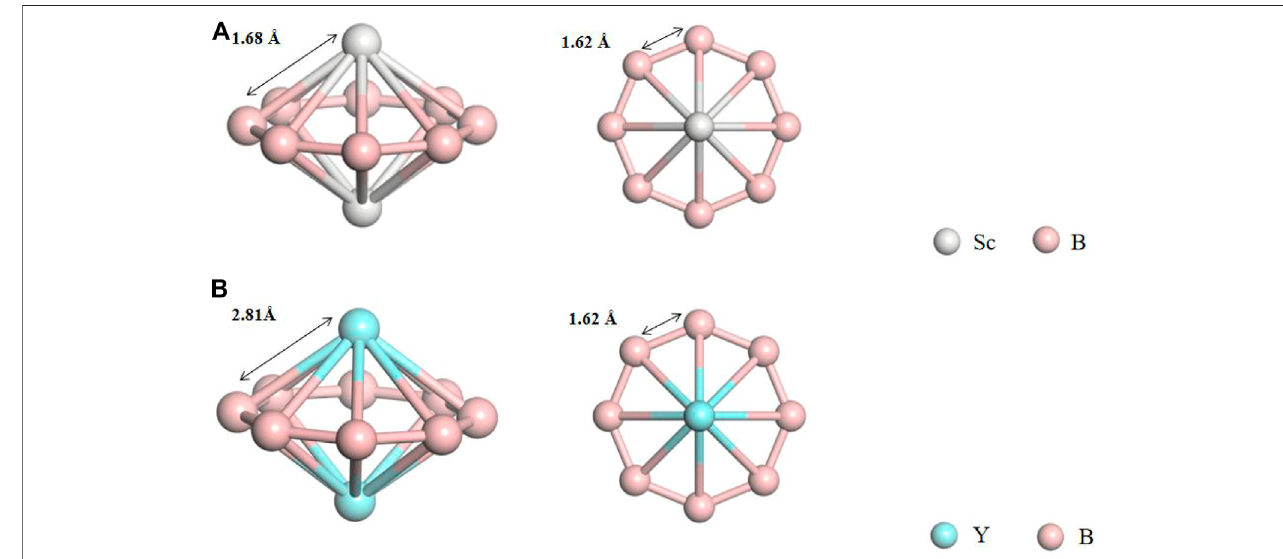
FIGURE 1 | Side and top views of the optimized Sc 2 B 8 (A) and Y 2 B 8 (B) clusters.